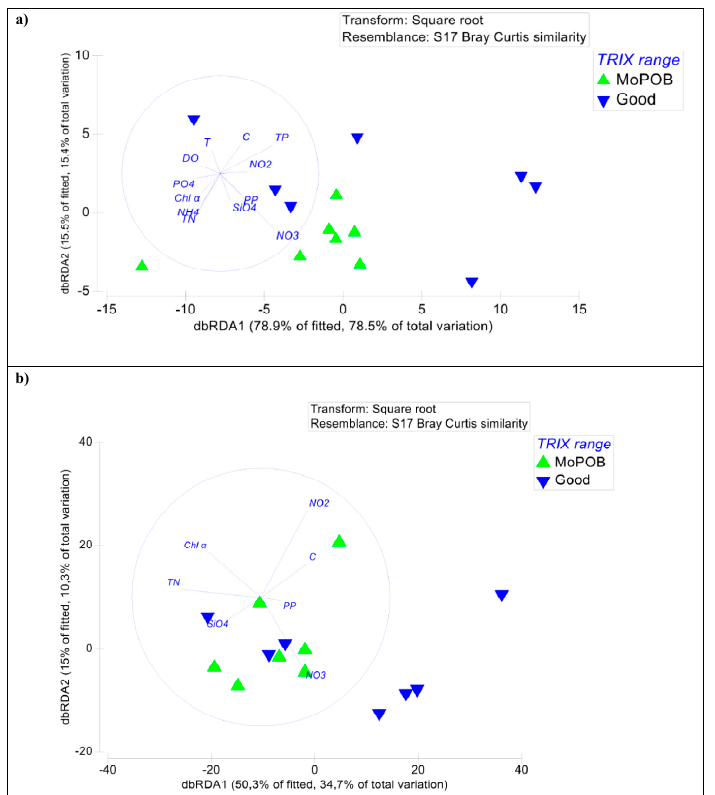
concentrations of NO 3 as well as other nitrogen forms (NO 2 , NH 4 , TN) and particulate organic carbon concentration (POC) increased with decreasing ecological quality (Table 1). However, the variation in other abiotic parameters within the group of MoPoB (i.e., temperature, salinity, density, SiO 4 , and POC concentrations) did not allow us to draw a firm conclusion about the relation between nutrients and viral community patterns in the examined coastal sites. In other words, while the relation detected here between the viral community and dissolved NO 3 was surely expected considering previous macro-diversity studies that revealed the strong dependence of the viral community patterns on the environment [37,53], we would need a larger dataset to validate this finding in the coastal zone too.